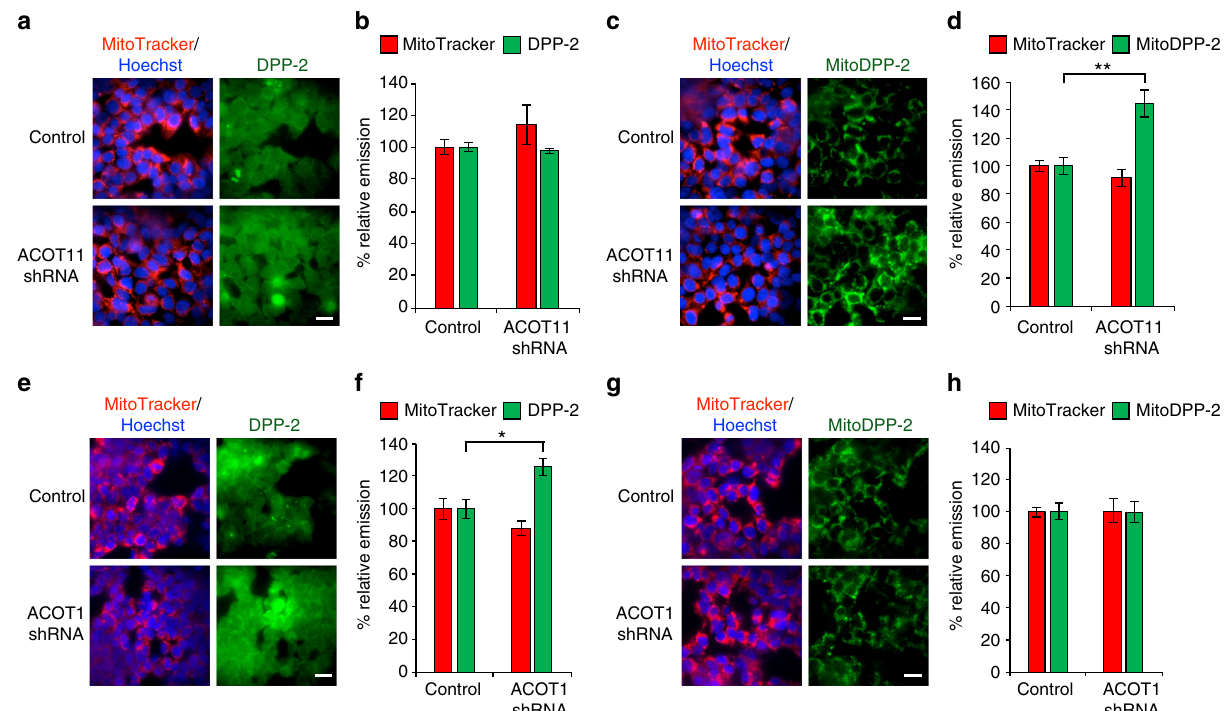
Fig. 9 ACOT11 and ACOT1 knockdown selectively perturbs mitochondrial and cytosolic S -deacylase activities. After transfection with either control or ACOT11 or ACOT1 shRNA vectors, HEK293T treated with 1 µ M Hoechst 33342, 100 nM MitoTracker Deep Red for 30 min, washed, loaded with 1 µ M DPP- 2 ( a , e ) or 500 nM mitoDPP-2 ( c , g ) for 10 min, and then analyzed by fl uorescence microscopy. b Quanti fi cation of experiment shown in ( a ). ACOT11 perturbation does not affect DPP-2 (cytosolic) signal. d Quanti fi cation of experiments shown in ( c ). ACOT11 knockdown causes an increase in mitoDPP-2 (mitochondrial) signal. f Quanti fi cation of experiment shown in ( e ). ACOT1 knockdown causes an increase in DPP-2 (cytosolic) signal. h Quanti fi cation of experiments shown in ( g ). ACOT1 perturbation does not affect mitoDPP-2 (mitochondrial) signal. For all imaging, 20 µ m scale bar shown. For all plots, statistical analyses performed with a two-tailed Student ′ s t -test with unequal variance, * P value < 0.05; ** P value < 0.007, n = 5 for ( a , c , e and g ), error bars are ±